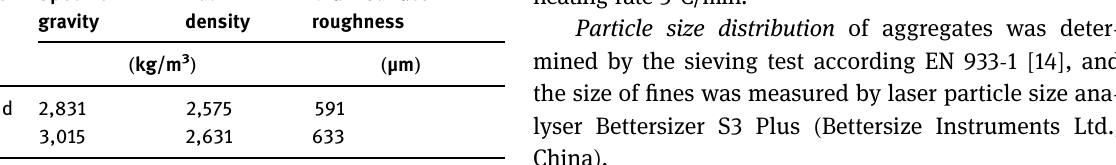
Table 1: Speci fi c gravity and bulk density of aggregates Aggregate